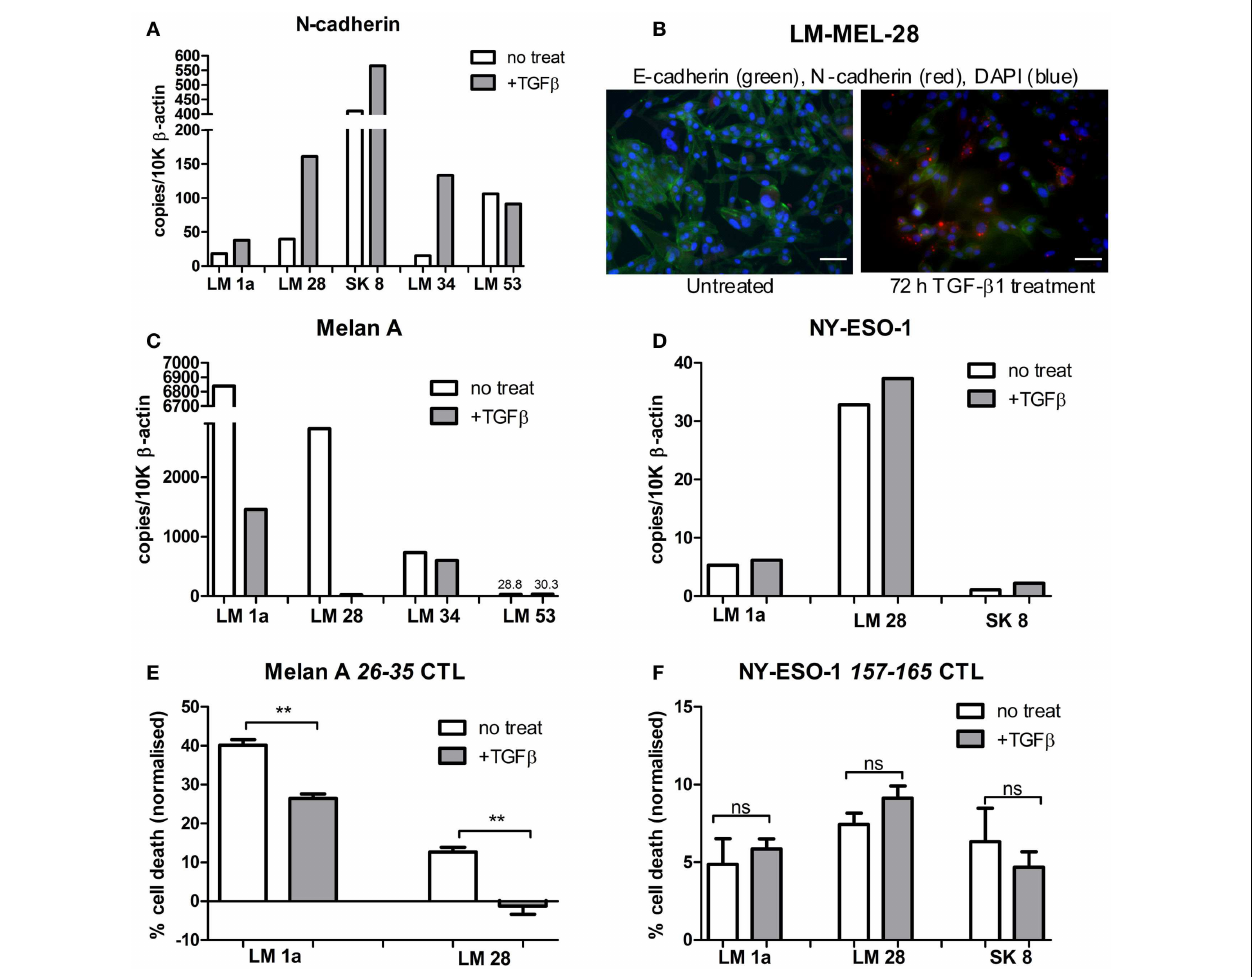
of (C) Melan-A and (D) NY-ESO-1 were compared betweenTGF β treated/untreated melanoma cell lines expressing these antigens. Melanoma cell lines expressing Melan-A, and/or NY-ESO-1 were treated with/without 5ng/mlTGF β for 72h. SpecificT cell clones, which recognized the HLA-A*0201 epitopes (E) Melan-A 26–35 or (F) NY-ESO-1 157–165 were incubated with 2 × 10 4 treated/untreated melanoma cells